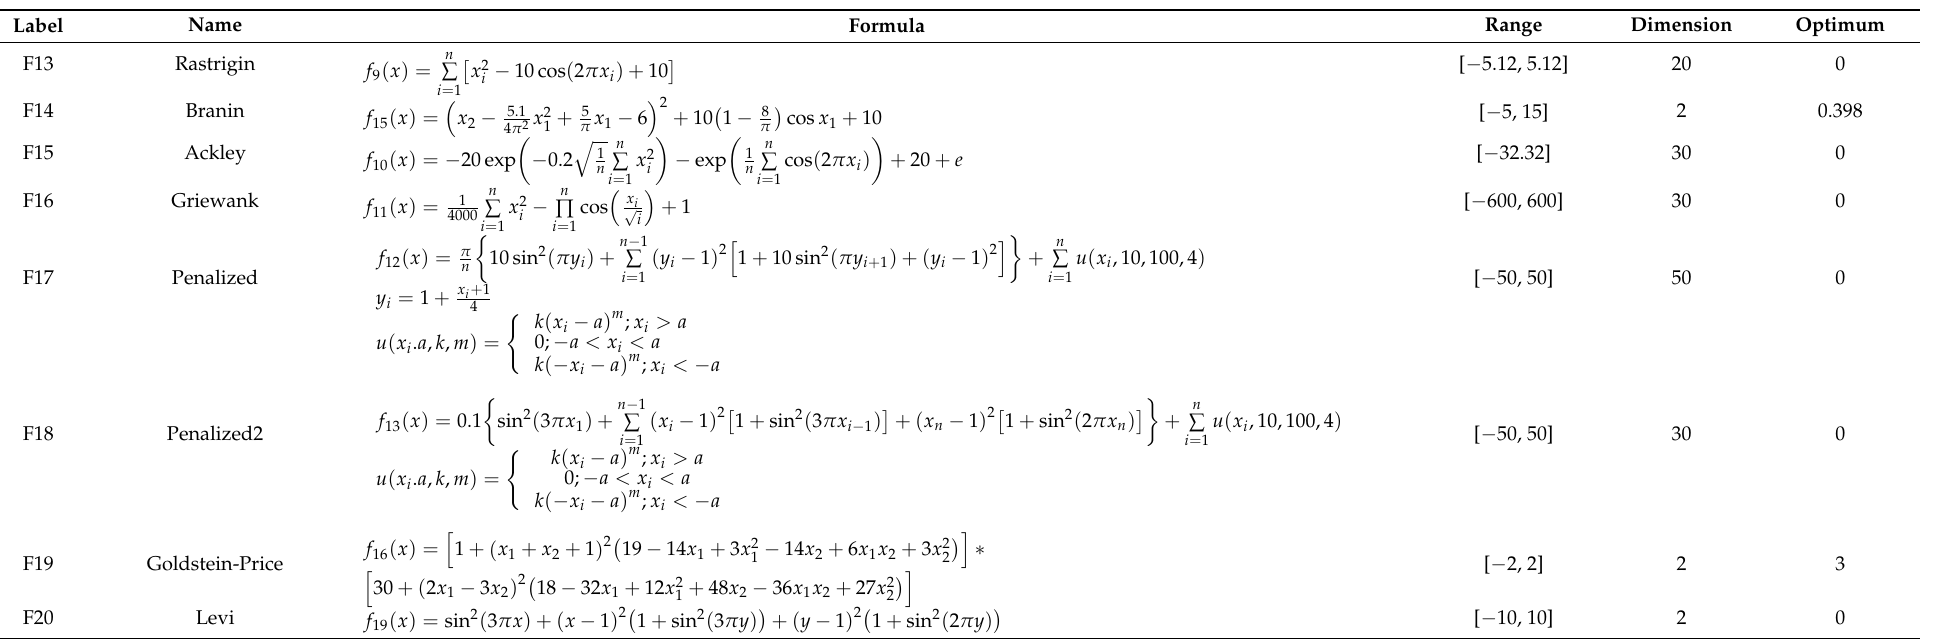
Table 2. Multimodal benchmark